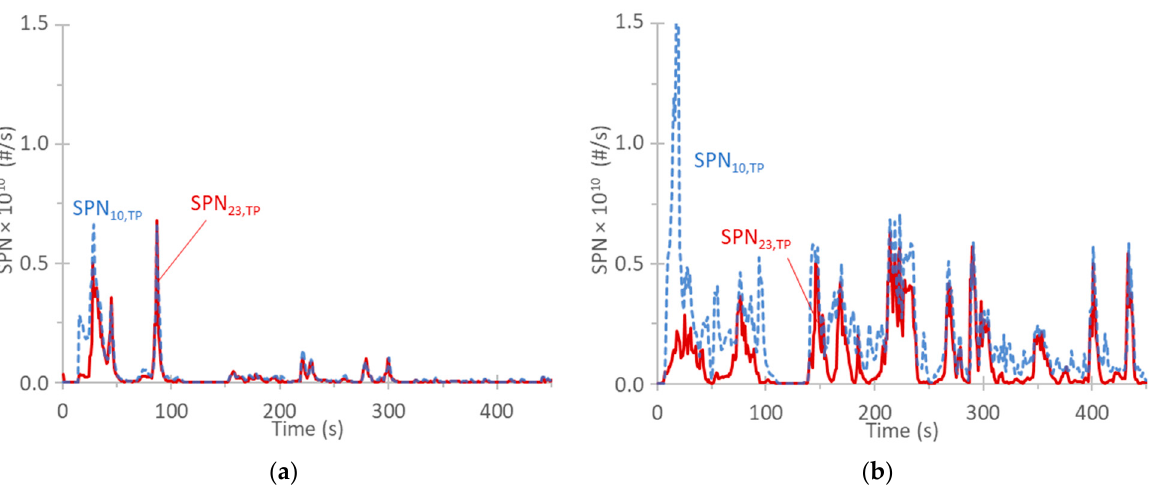
Figure A1. Solid particle number (SPN) emissions measured from the tailpipe (TP): ( a ) Vehicle #1 (Euro 6d-Temp); ( b ) Vehicle #2 (Euro 6b).